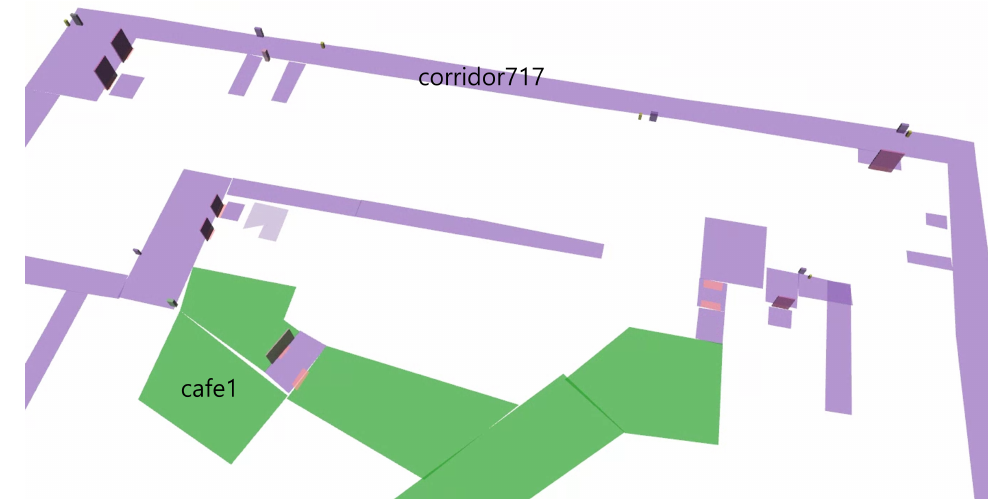
Figure 10. The explicit model-based visualization of the generated semantic map for the corporate collaboration center at Sungkyunkwan University